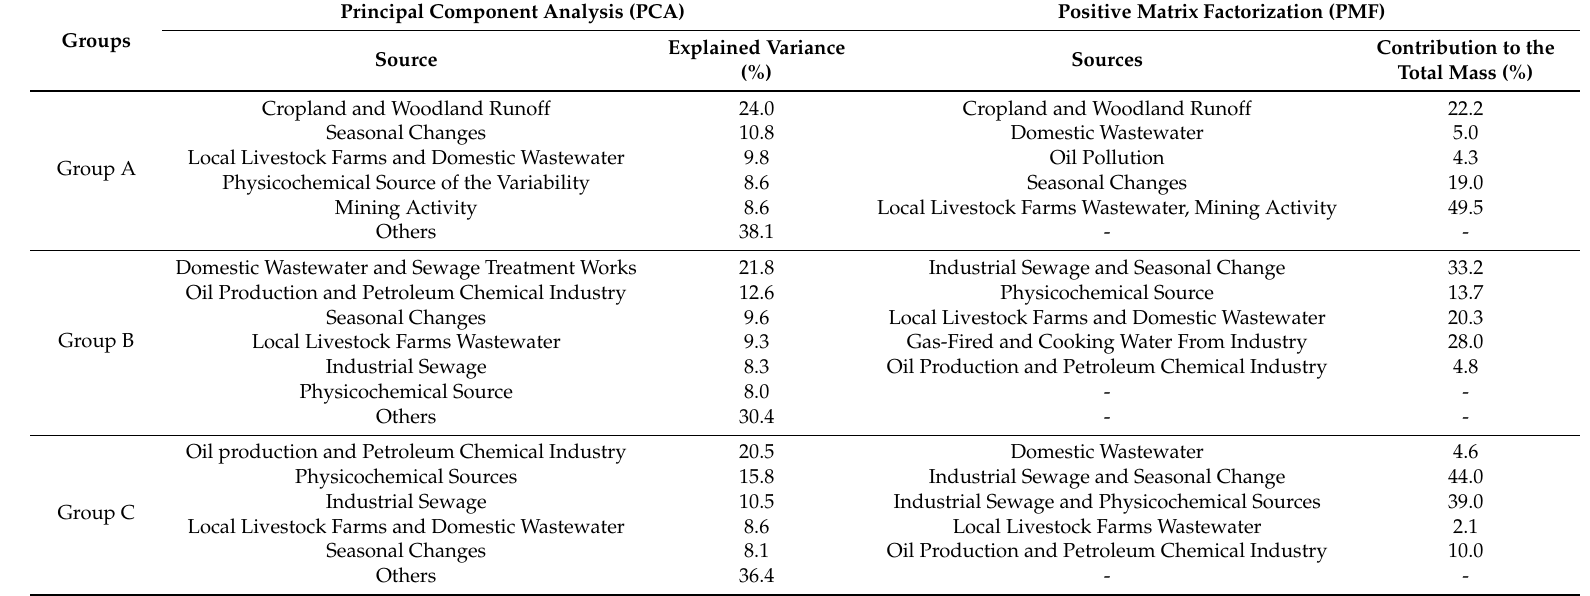
Table 6. Results from two different multivariate statistical